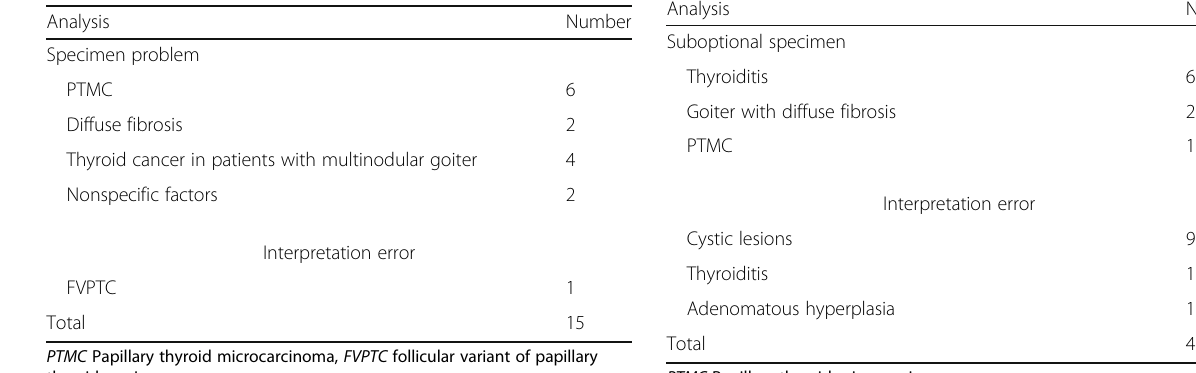
Table 4 The analysis for the false-positive cases Analysis